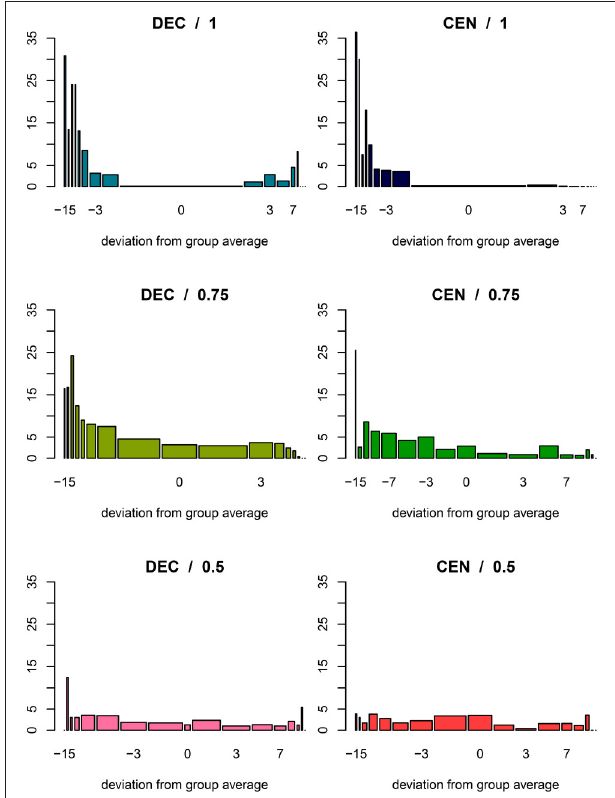
FIGURE 2 | Received punishment. Barplot of average deducted income by difference between own contribution and average group contribution. Except for 0, categories show intervals of length 2: “ − 16 to − 14”, “ − 14 to 12” ... “ − 2 to < 0”, “0”, “ > 0–2”, ...“14–16”. Width of bars is proportional to number of